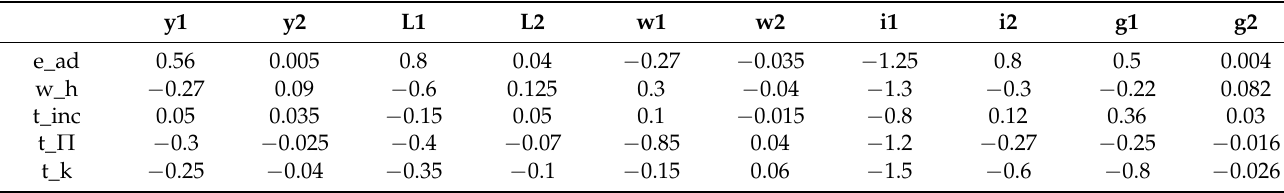
Table 2. Elasticities (maximum) per unit change in